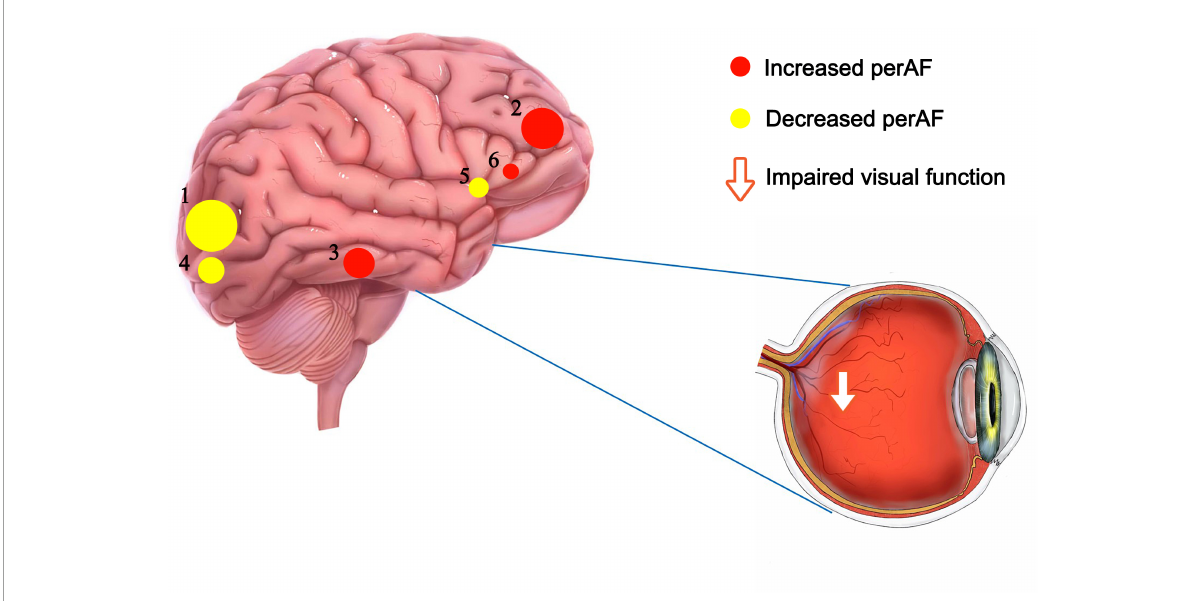
FIGURE4 The mean perAF values of altered brain regions. Notes: Compared with the HCs, the perAF values of the following regions were increased to various extents: 2- Frontal_Sup_Orb_L/Frontal_Inf_Orb_L (t = -5.03), 3- Temporal_Inf_L (t = -4.92), 6- Frontal_Inf_Oper_L (t = -4.41). Compared with the HCs, the perAF values of the following regions were decreased to various extents: 1- Occipital_Mid_L (t = 5.21), 4- Occipital_Mid_R (t = 4.595), 6- Cingulum_Mid_L (t = 4.531). HCs, healthy controls; BA, Brodmann’s area.